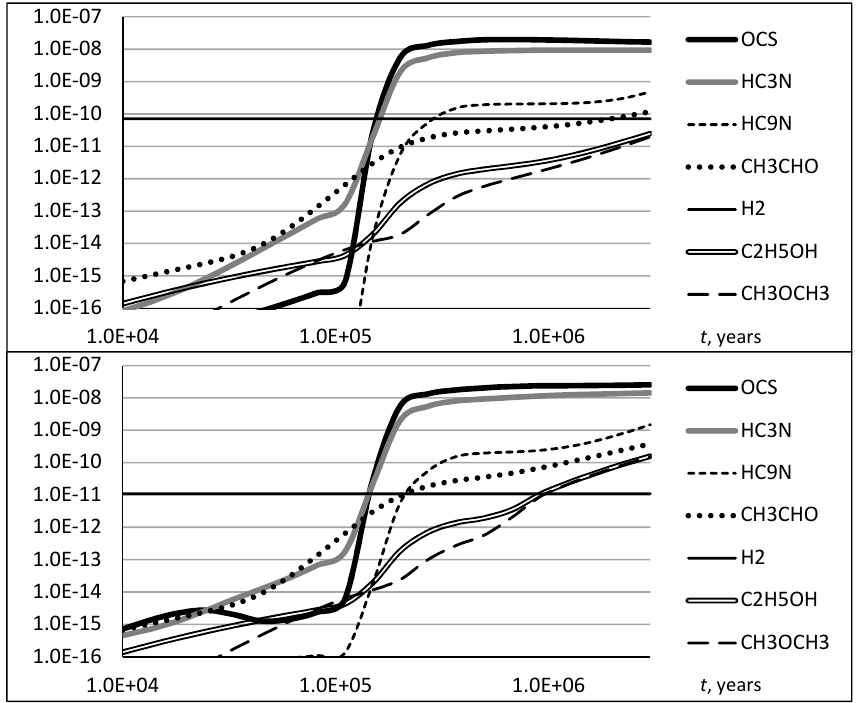
Fig. 4. Comparison of relative abundances for selected species. Top panel – the reference model, bottom panel – the model with CR-induced surface-cavity diffusion. Note that the ice abundance of H 2 is a